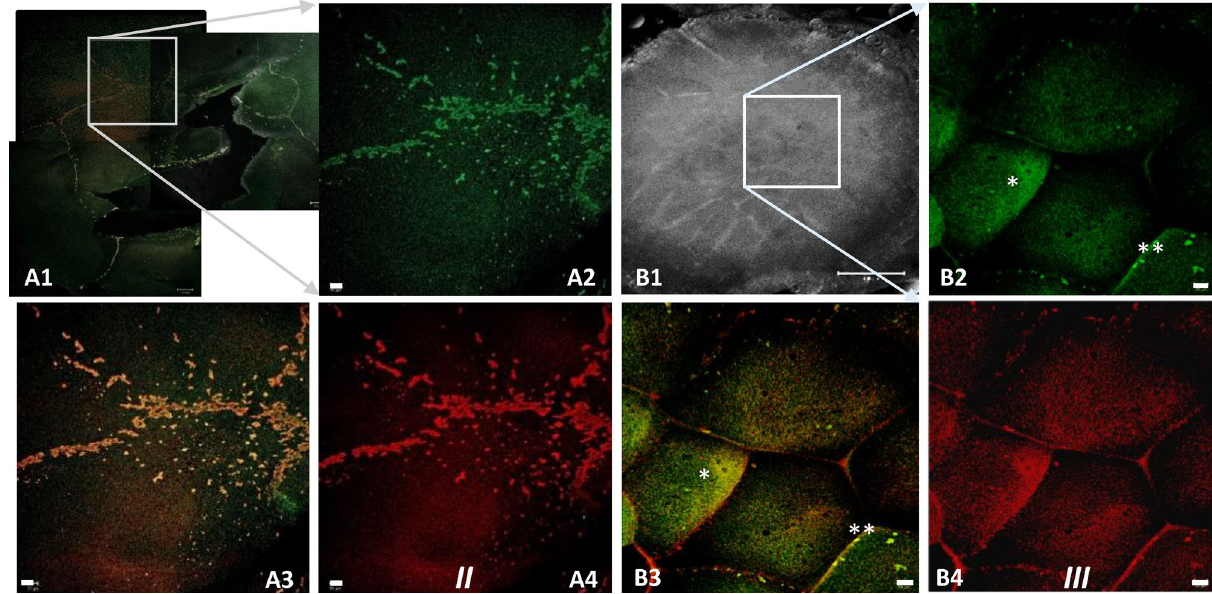
Figure 6. Co-localization of Bucky ball and CVH during stages EK I to EK III. During the first two cleavage stages (EK I and EK III), Bucky ball strictly co-localized to CVH within the cleavage furrows and in condensed granules in the cleavage center A: ( A1 ) stitched fluorescent overlay images of the central region of an EGK II embryo with the indicated region of high resolution images shown in ( A2–A4 ) ( A2 ) Bucky ball, ( A3 ) CVH, ( A4 ) overlay. ( A2—A4 ) are included in a preprint 51 . During the next stage, EK III, both germ plasm proteins translocate into the cytoplasm of the first forming central cells B: ( B1 ) transmission image of the total embryonic disc at stage EGK III with indicated central region for high resolution fluorescent imaging: ( B2 ) Bucky ball, ( B3 ) CVH, ( B4 ) overlay. Asterisk indicate the diffusion of Bucky ball and CVH proteins into the cytoplasm. Scales 20 µm, except ( B1 ) = 500 µm.